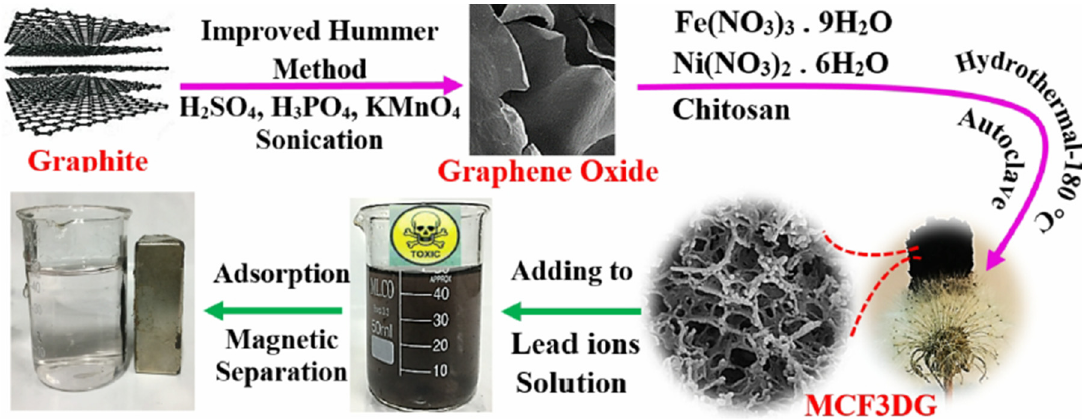
Figure 9. Synthesis of magnetic chitosan-functionalized 3D graphene nanocomposite MCF3DG (Reproduced or adapted from ref. [62], with permission from American Chemical Society, 2020).